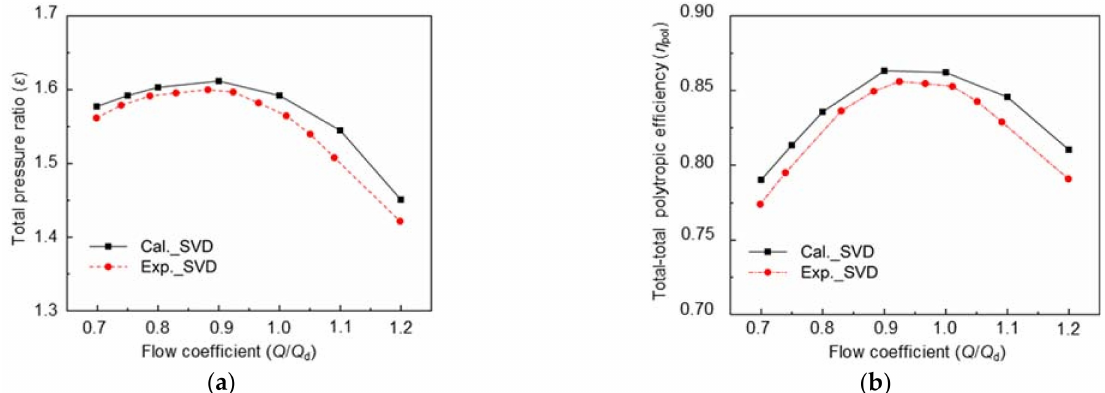
Figure 5. Comparison of CFD-predicted results with experimental data for the stage with SVD: ( a ) total pressure ratio; ( b ) total to total polytropic